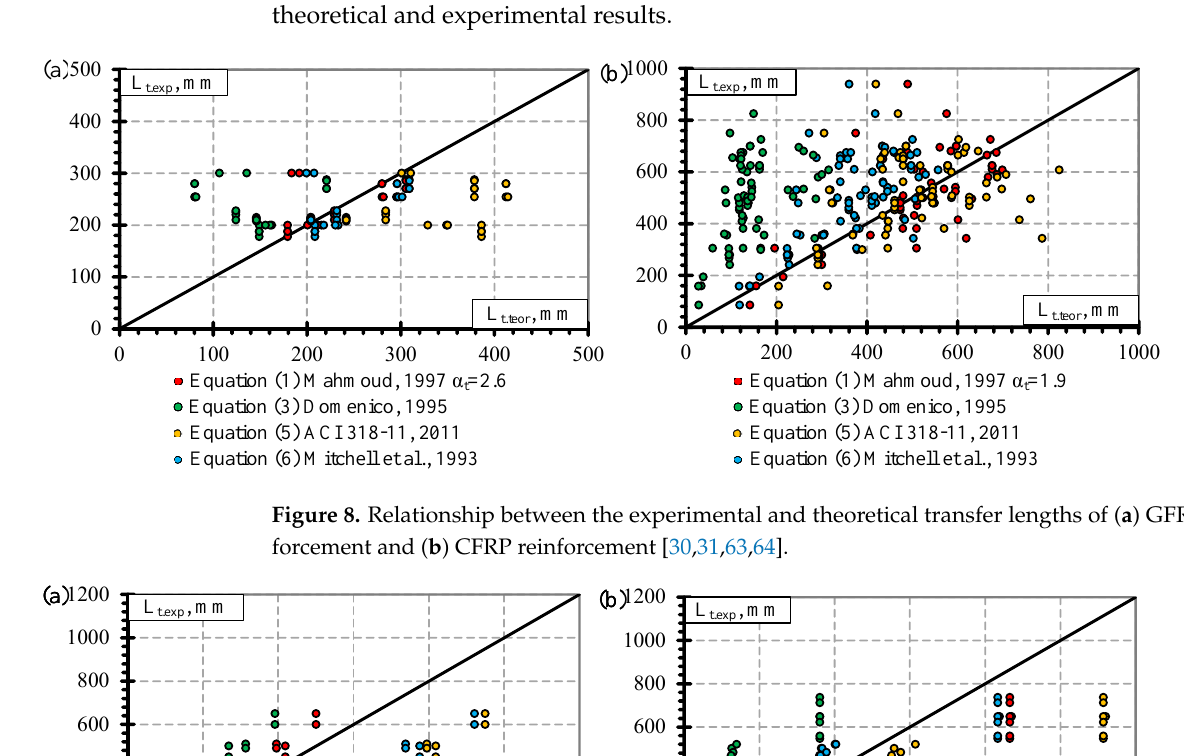
the results is the lowest (COV = 12%). Therefore, it shows the best agreement between theoretical and experimental results.